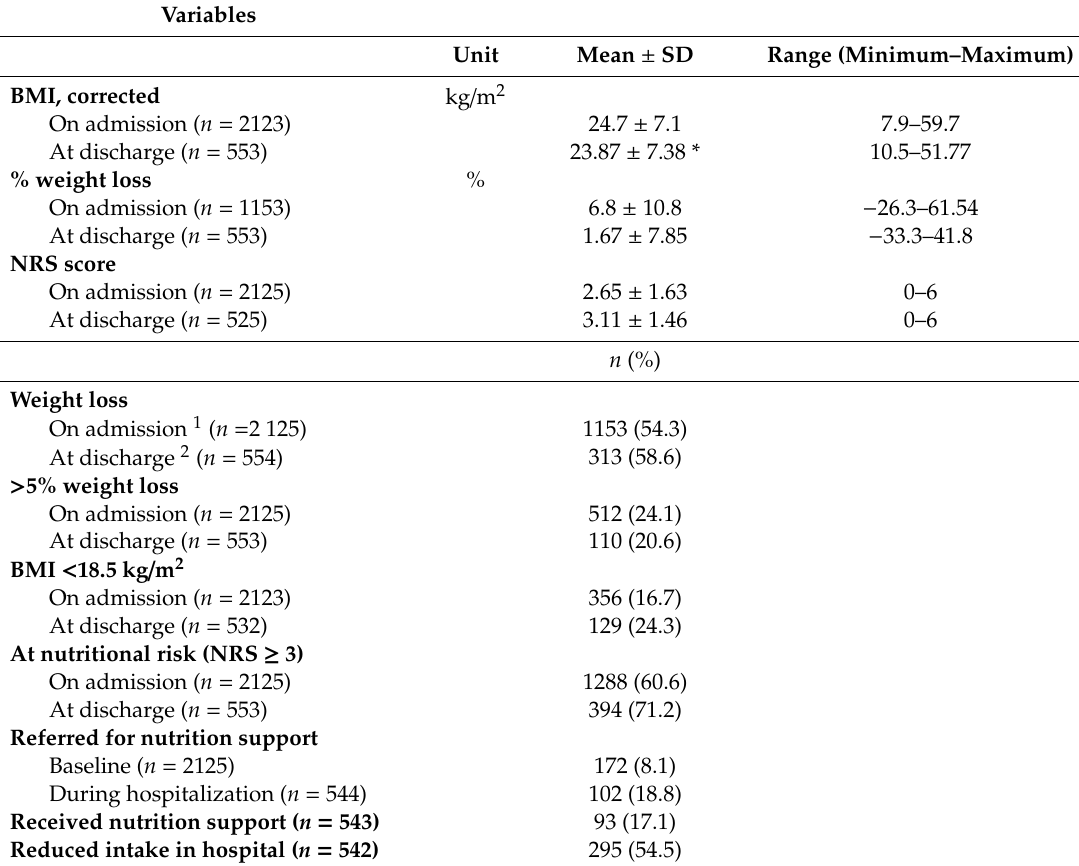
Table 3. Nutritional variables on admission versus